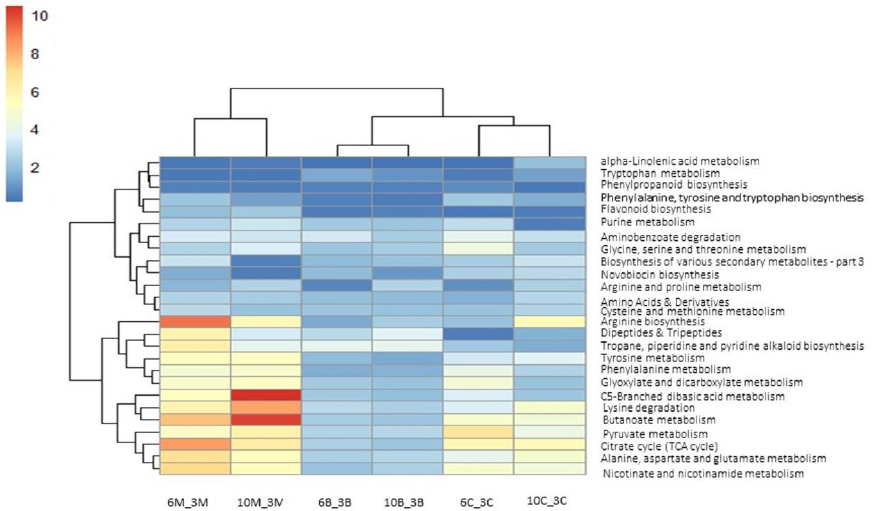
Figure 12. Heatmap showing the differentially expressed plant metabolic pathways in comparisons between the same treated plants at different Dpi.